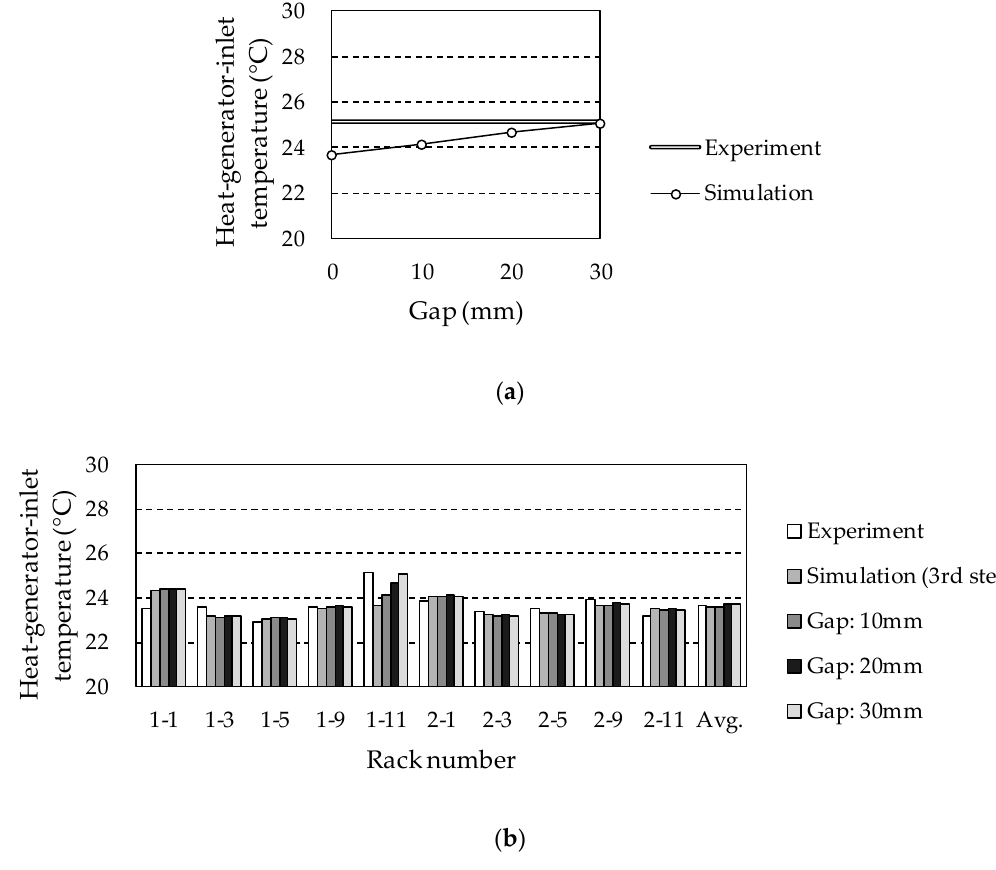
Figure 7. Change in the prediction result of heat-generator inlet temperature by reproducing the gap of the part contacting the vertical member of the cold-aisle containment (CAC) and the rack number 1-11 at CRAC fan frequency of 63 Hz (G 3 ): ( a ) prediction result of rack number 1-11 and ( b ) prediction result of all racks.